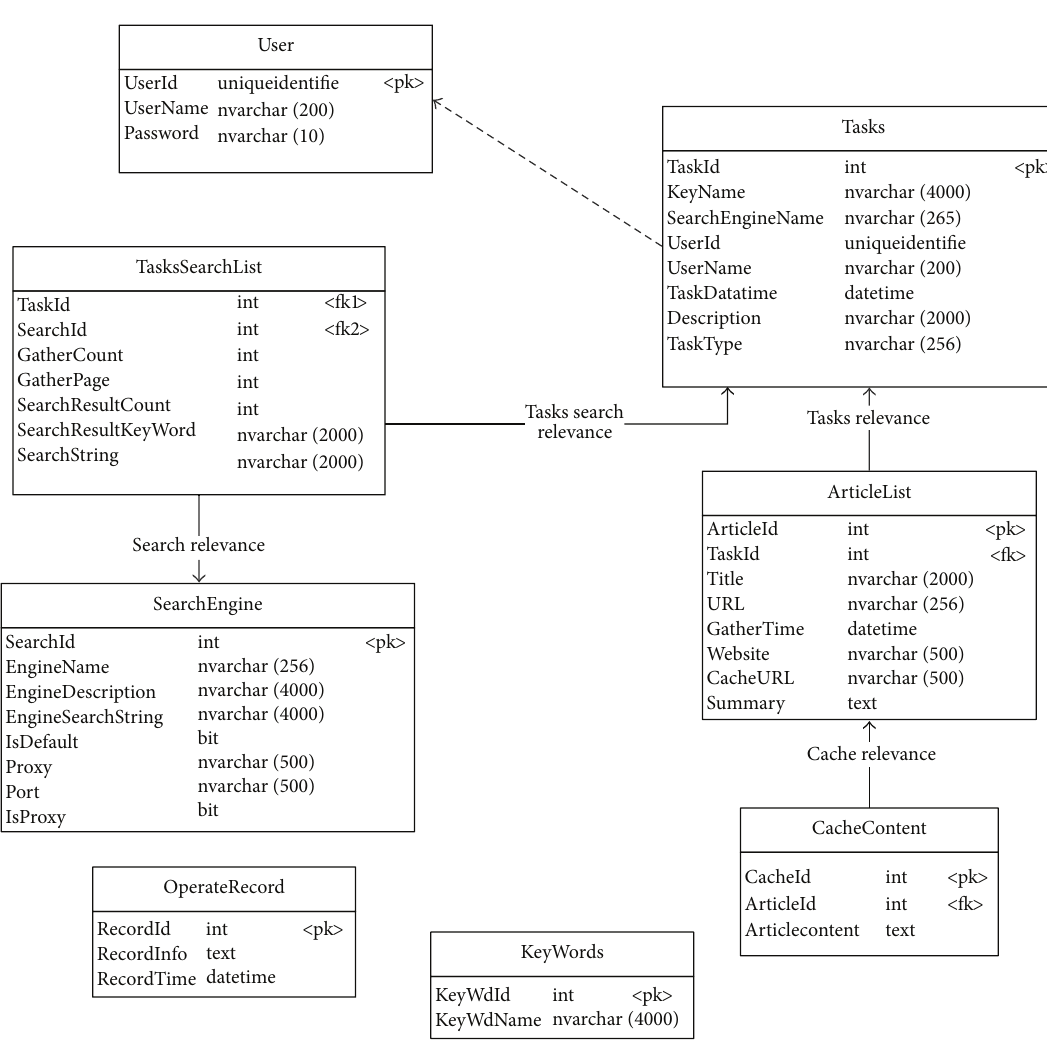
Figure 1: Database